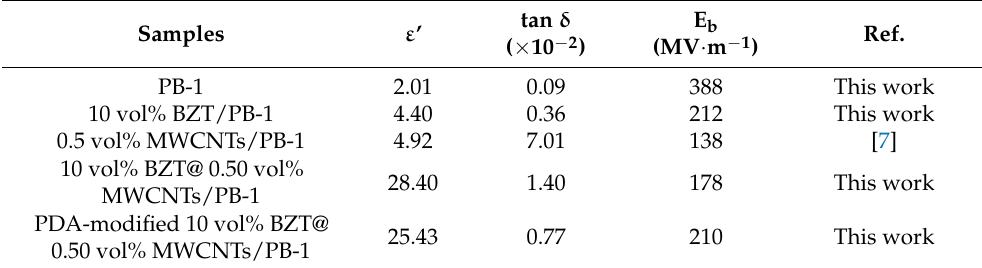
Table 1. The dielectric performance of PB-1 composite films at 1